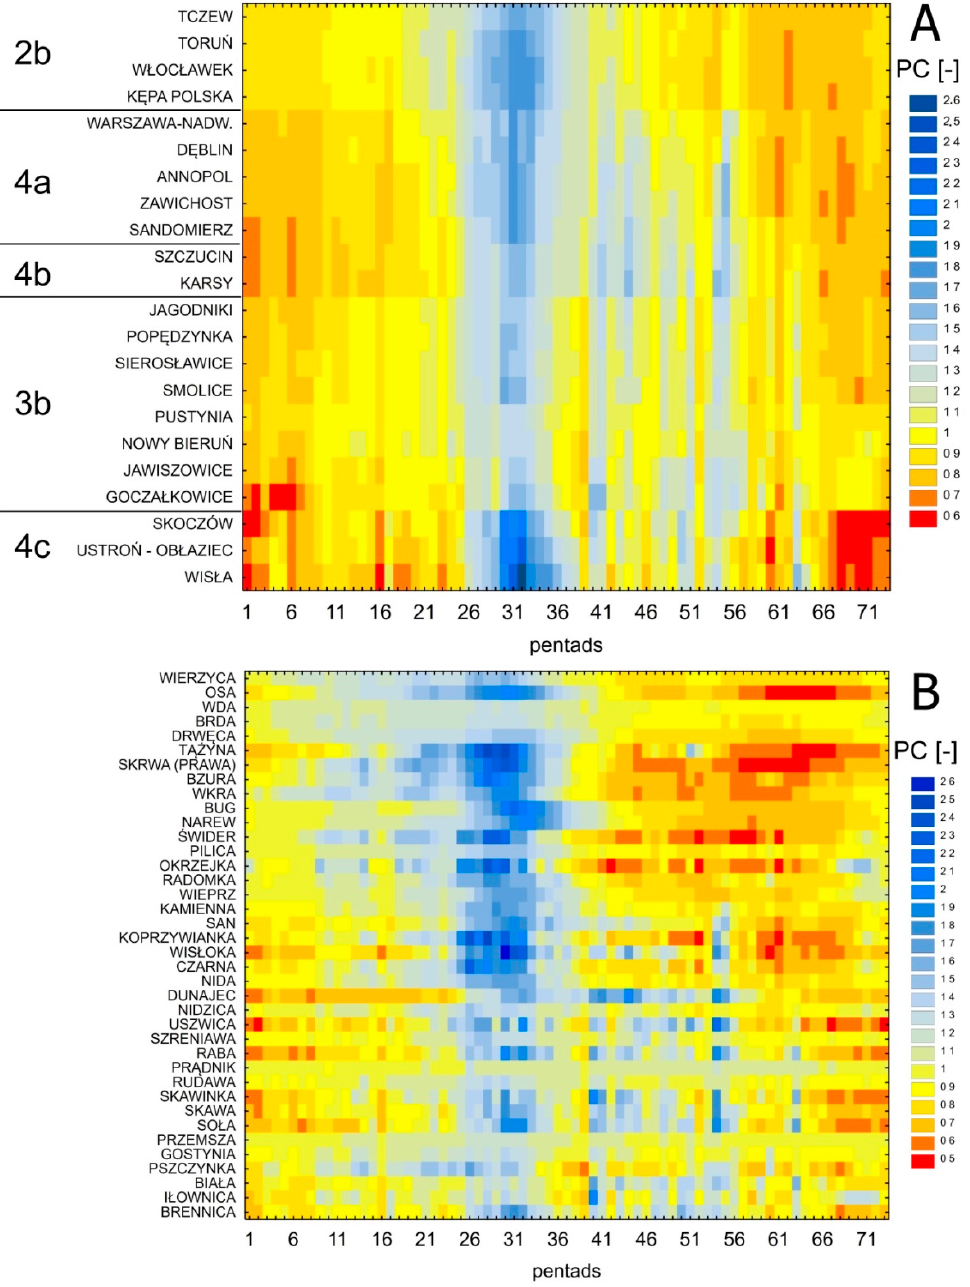
Figure 6. Coefficients of pentadic flow (PPC) along the course of the Vistula River ( A ) and its tributaries ( B